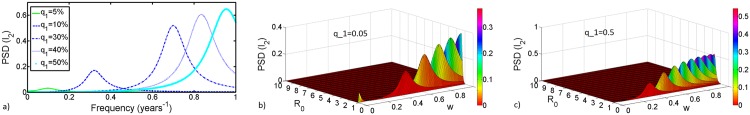
Power Spectra Density (PSD) for the variable I2 (Eq (13)).a) Effects of vertical transmission efficiency on the PSD. Three-dimensional representation of the PSD when varying R0 and the frequency for q1 = 0.05 and q5 = 0.5 in b) and c) respectively. Model parameter values used are as follows: β12 = 0.170, β21 = 0.116, ϵ2 = (1/4) ∗ 360, α′ = α = 256, μ2 = 1/8, m0 = 1.5, μ1 = (1/16) ∗ 360.